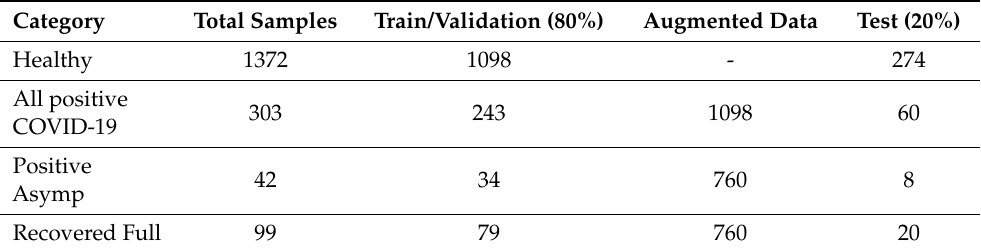
Table 3. Summary of sample sizes used for each classes.